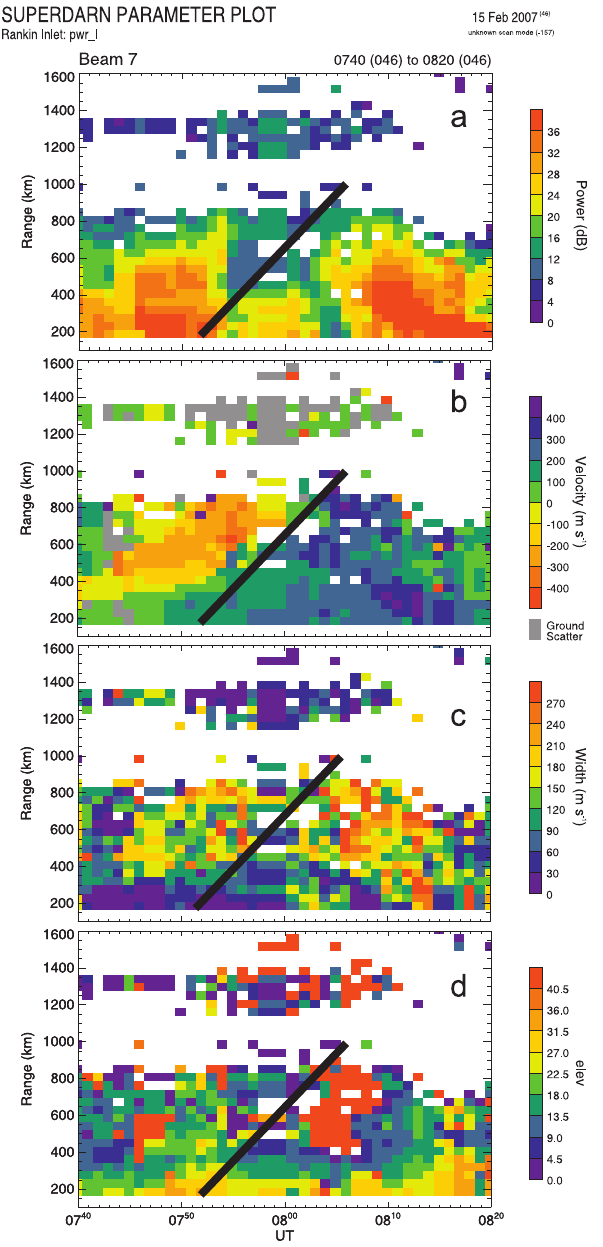
Fig. 6. Echo power, velocity, spectral width and elevation angle according to RANK measurements in beam 7 between 07:40 and 08:20UT. Vertical sloped line is a marker introduced for conve- nience of the